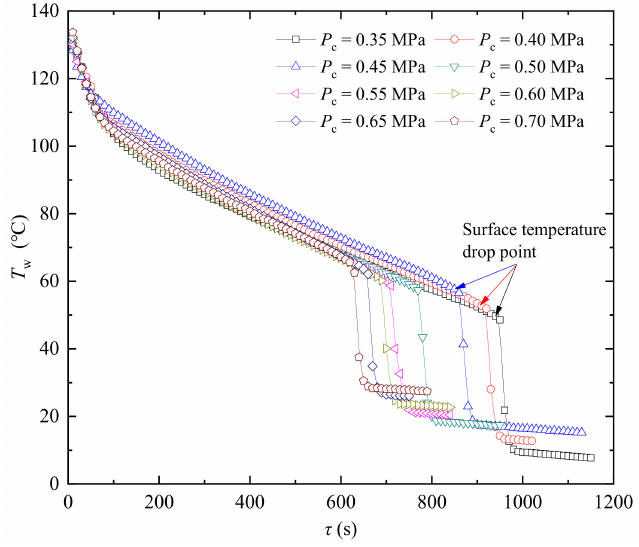
Figure 12. Curves of surface temperature with time during the dissipating